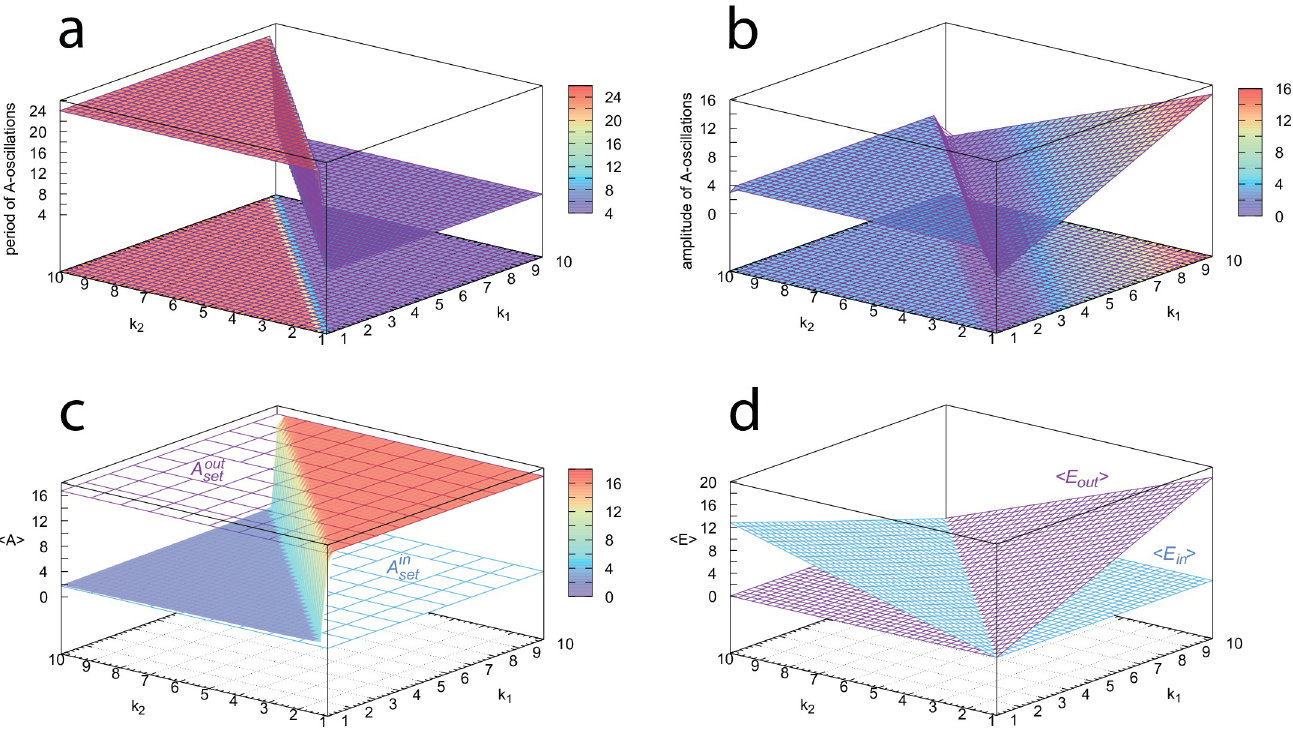
Fig 6. Overview of the oscillatory properties of combined motifs m3 and m5. (a) The period switches in dependence whether the inflow or the outflow controller is dominating. (b) Amplitude of the A -oscillations. (c) The controllers’ < A > values follow closely their set-points. (d) Average values of the oscillatory E in and E out concentrations and their up-regulation in dependence of the perturbations. Rate constants and initial concentrations as for the oscillatory case in Fig 5. All properties were calculated after 500 time units when (oscillatory) steady state conditions were established. See also S2 Gnuplot for an interactive visualization of each